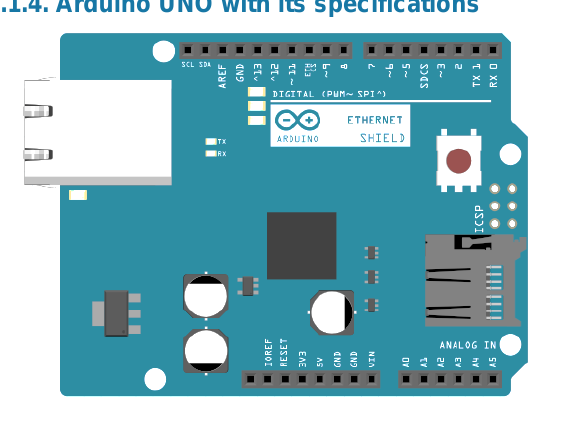
Figure 5. Microcontroller Arduino UNO